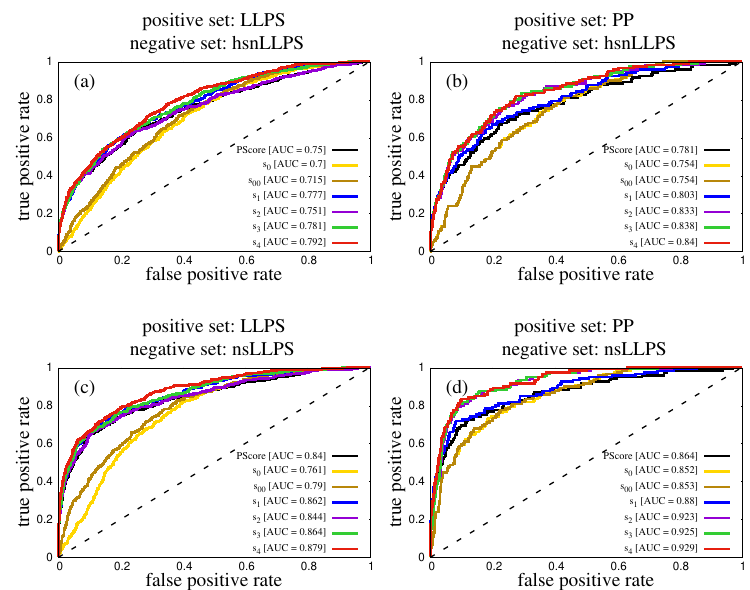
Figure 4. ROC curves corresponding to different predicting scores. The dashed line represents the random classifier. ( a ) LLPS positive set, hsnLLPS negative set. ( b ) PP positive set, hsnLLPS negative set. ( c ) LLPS positive set, nsLLPS negative set. ( d ) PP positive set, nsLLPS negative